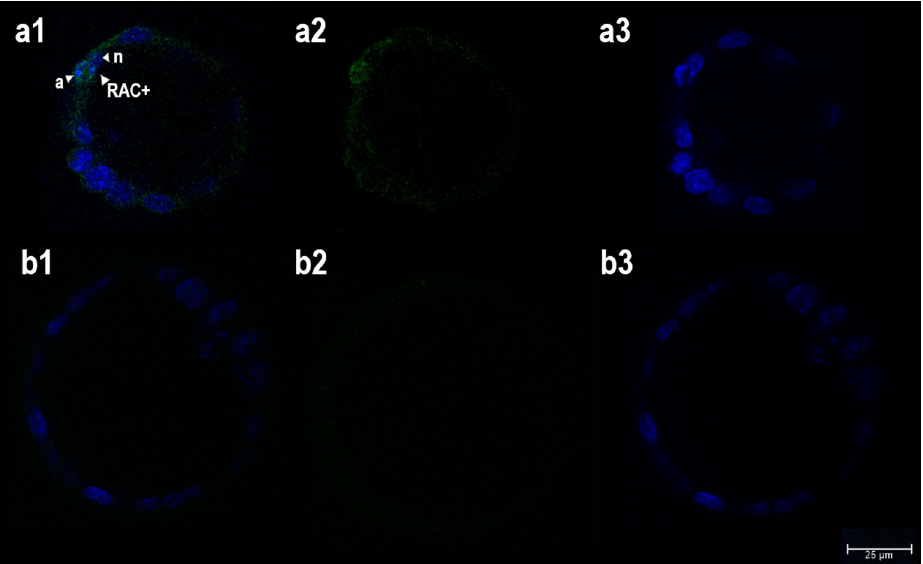
Figure 4. Analysis of phagosome formation in mouse blastocysts. Images were obtained by confocal laser scanning microscopy (magnification × 400). Single optical sections of two blastocysts are shown in the pictures ( a,b ). ( a ) Immunochemical staining of RAC1 ( a2 , green) combined with Hoechst 33342 DNA staining ( a3 , blue) ( a1 : merge). ( b ) Negative control staining ( b2 , omission of primary antibody) combined with Hoechst 33342 DNA staining ( b3 , blue) ( b1 : merge). ( a1 ) presence of RAC1 (RAC +) in a membrane-like formation surrounding one nucleus with a condensed morphology (a) next to nucleus with normal morphology